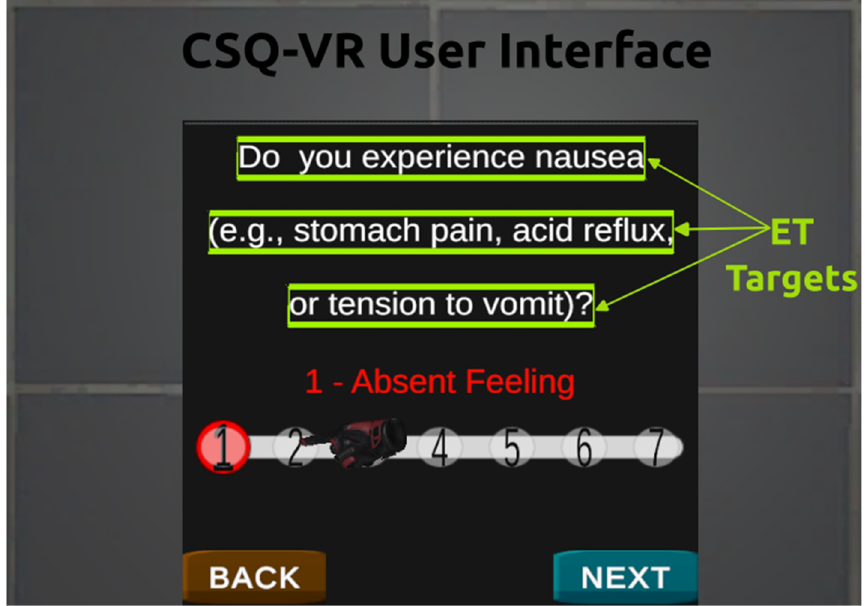
Figure 3. User Interface and Eye-Tracking (ET) Targets of the VR version of CSQ-VR. Note: Eye- tracking targets were not visible to the user.